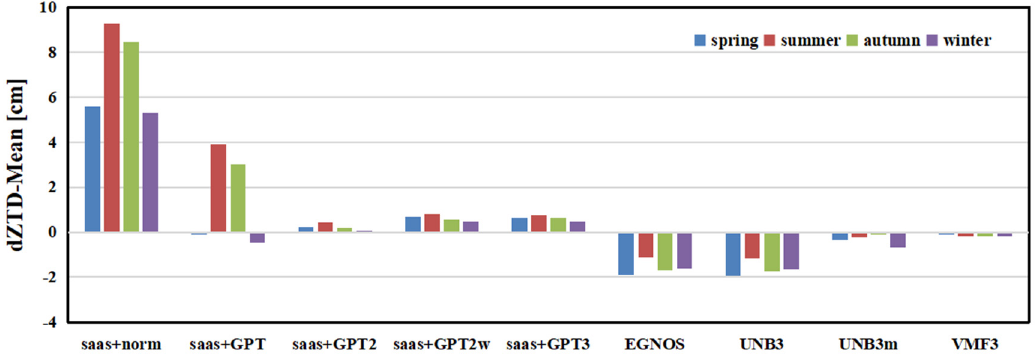
Figure 3. Mean between the IGS ZTD and the 9 models (saas+norm/GPT/GPT2/GPT2w/GPT3, EGNOS, UNB3, UNB3m, VMF3) in different seasons.